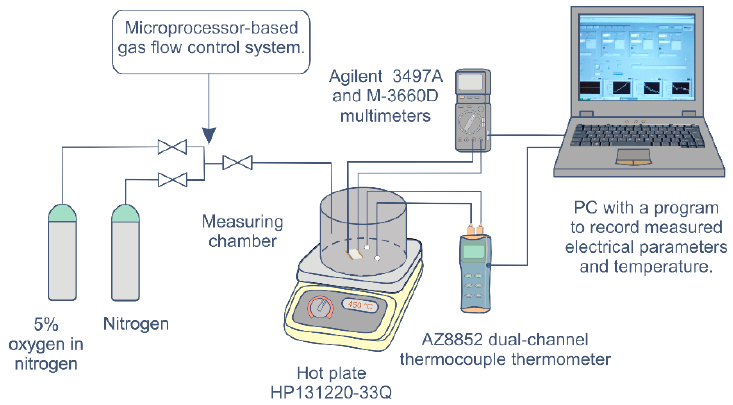
Figure 2. Schematic of the measuring system.